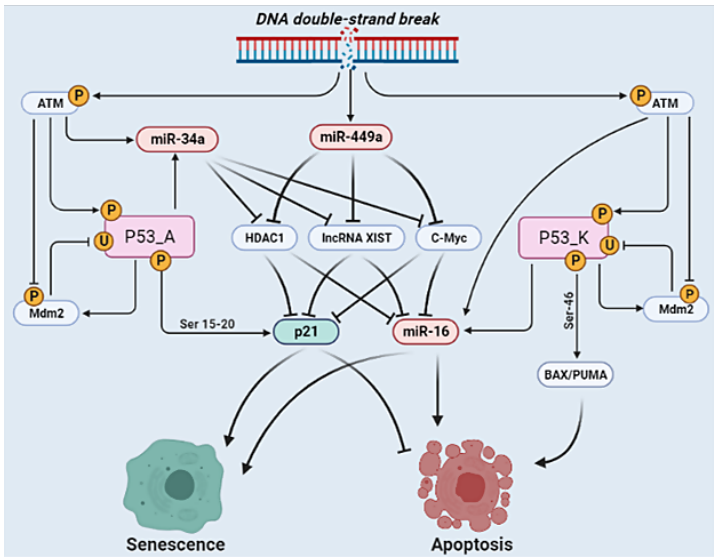
Figure 3. Molecular mechanisms of p21 and miR-16 through the miR-449a in response to DNA damage in NSCLC. DNA double-strand break (DSB) can be caused by the radiomimetic chemicals or reactive oxygen species (ROS) or radiation, which triggers autophosphorylation of ATM at serine 1981 by initiating its kinase activity [64]. Downstream phosphorylation on the ATM pathway drives the activation of p53 in response to DNA damage. ATM directly induces Mdm2 phosphorylation, thereby reducing the activity of Mdm2 and resulting in strong induction of p53. Activated p53 induces Mdm2 which inhibits p53 by ubiquitination [49]. Within the model, based on the different phosphorylation events that p53 controls, it is described by two variables: p53-A and p53-K. p53-A represents p53 phosphorylated at serine 15 and serine 20 that induce p21 expression for the cell cycle arrest or senescence, whereas p53-K specifies further phosphorylation at serine 46 that modulates Bax and/or PUMA expression for the apoptosis (see [33] for more information on p53-A/p53-K function). Activated ATM/p53 can induce miR-34a [50,65] and miR-16 [66,67] expression in DNA damage response. On the other hand, miR-449a induced through the DNA damage as suggested by Mao et al. [21]. HDAC1, lncRNA XIST and C-Myc are well-known inhibitors of p21 [68–70] and miR-16 [15,71,72]. Interestingly, HDAC1, lncRNA XIST, and C-Myc are directly targeted by the miR-449a [14,21,73] and miR-34a [16,36,74]. Consequently, miR-449a can regulate p21 expression and miR-16 activity through the suppression of HDAC1, lncRNA XIST, and C-Myc. Once p21 expression and/or miR-16 is activated, it can trigger senescence and/or apoptosis in NSCLC at the G1/S checkpoint. Arrowhead edge represents activation. Whereas, a hammer-head edge represents suppression, respectively. Detailed molecular mechanism of DNA damage of the model see our previous publish study [17] and also the latest reviewed article by Huang et al.